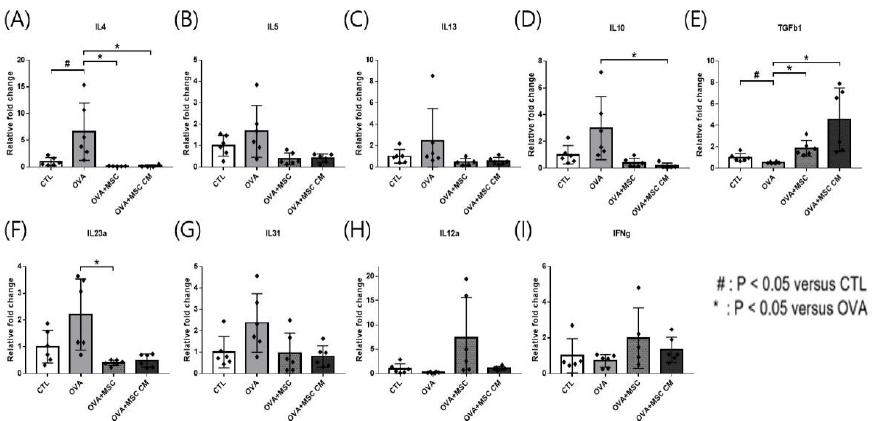
Figure 4. OVA challenge upregulated inflammatory cytokines and IL-10 transcription, downregu-lated TGF- β1 and MSC or MSC CM reversed the change in the SI. ( A ) IL-4, ( B ) IL-5, ( C ) IL-13, ( D ) IL-10, ( E ) TGF- β 1, ( F ) IL-23 α , ( G ) IL-31, ( H ) IL-12 α , and ( I ) IFN- γ mRNA level changes in the SI measured by qPCR are shown. Each value indicates mean ± standard error of the mean. # p < 0.05 versus CTL, * p < 0.05 versus OVA, CTL, control; IL, interleukin; MSC, mesenchymal stem cell; MSC